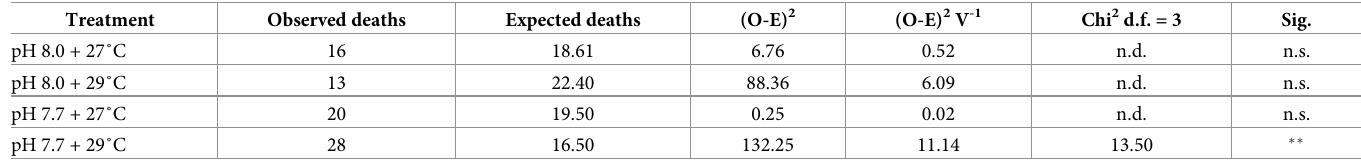
Table 1. Germling survival probability and R statistical analysis of survival using Kruskal-Wallis rank sum tests to determine significant differences in survival at varying treatment conditions.